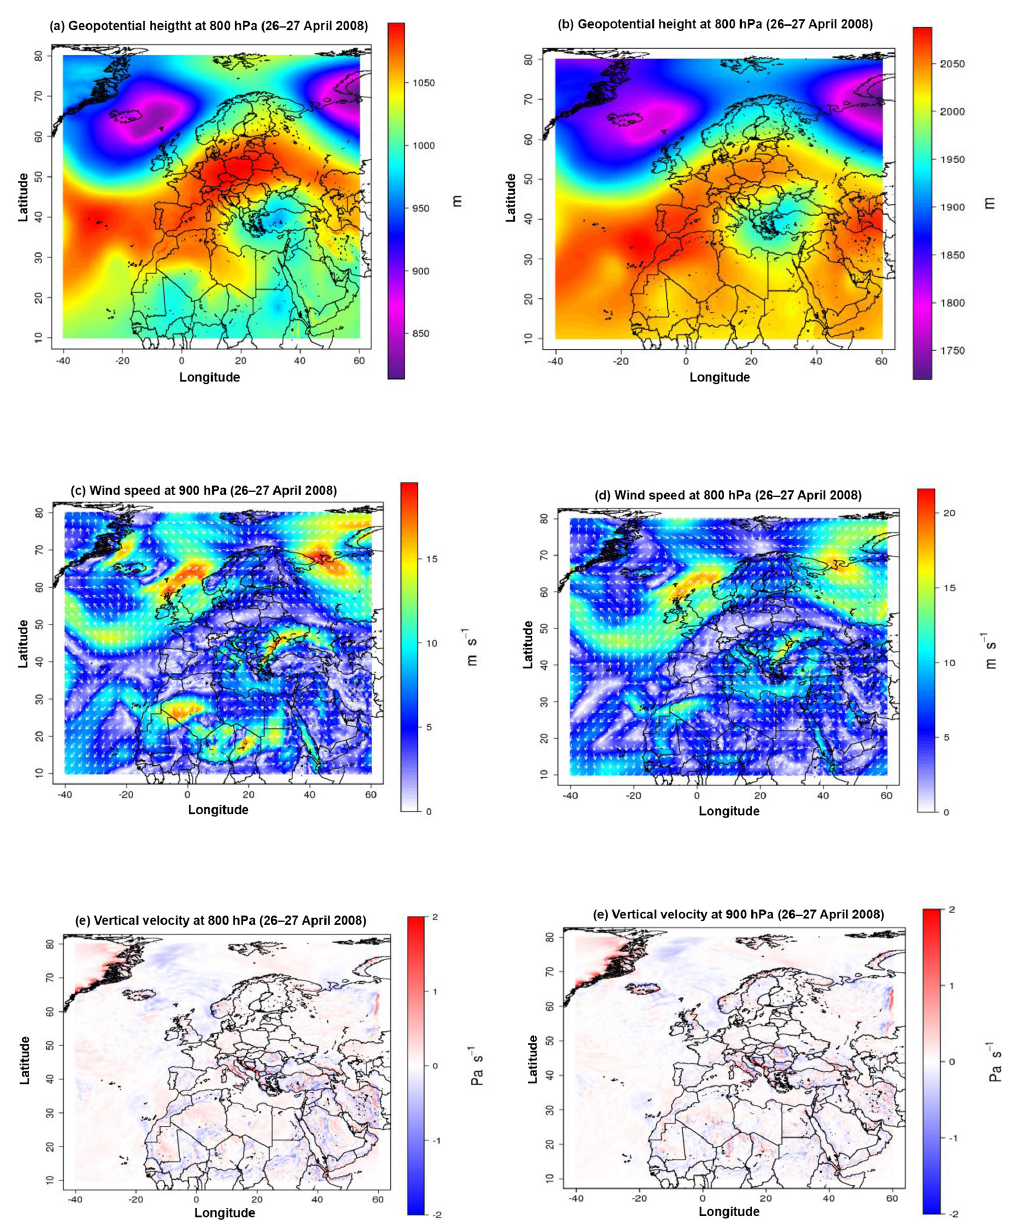
Figure 3. Composite ECMWF meteorological charts of geopotential height ( a, b , in m); wind speed ( c, d ; in ms − 1 ) and vertical velocity ( e, f ; in Pas − 1 ) at 900hPa (left) and 800hPa (right) for the high ozone episode of 26–27 April